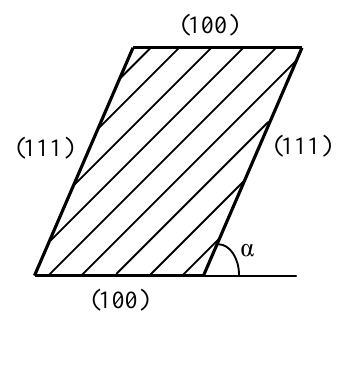
Figure 2. Cross section of the slanted